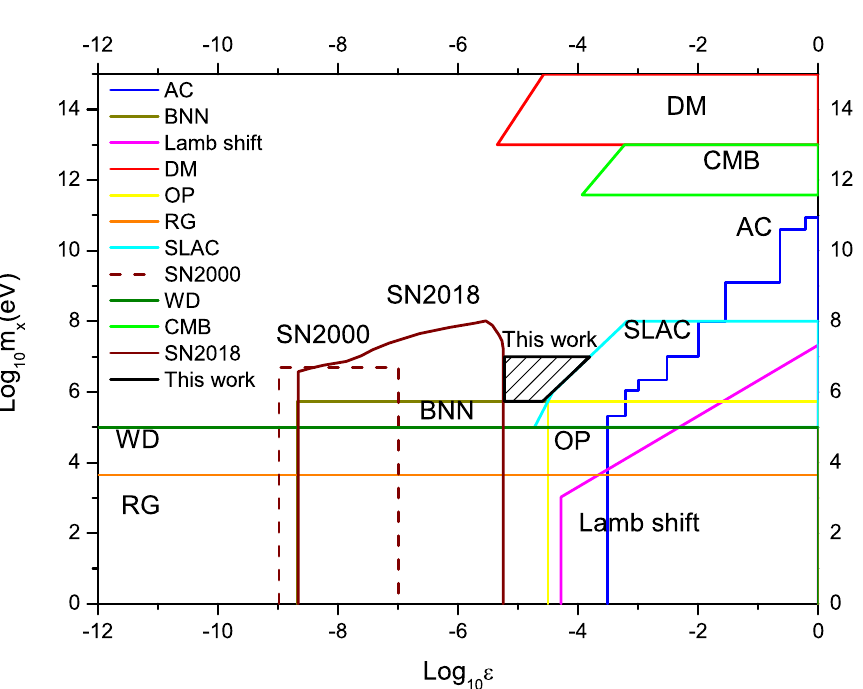
Figure 5 . If m φ =3 TeV, with τ φ = 10 19 s, a new region (shaded region) is ruled out in the m MCP vs. (cid:15) plane, when m MCP < 10 MeV and (cid:15) > 5 . 9 × 10 − 6 (this work). Meanwhile, the bounds from plasmon decay in red giants (RG) [23], plasmon decay in white dwarfs (WD) [23], cooling of the Supernova 1987A (SN2000 [23], SN2018 [22]), accelerator (AC) [24] and fixed-target experiments (SLAC) [25], the Tokyo search for the invisible decay of ortho-positronium (OP) [28], the Lamb shift [29], big bang nucleosynthesis (BBN) [23], cosmic microwave background (CMB) [48] and dark matter searches (DM) [49] are also plotted on this